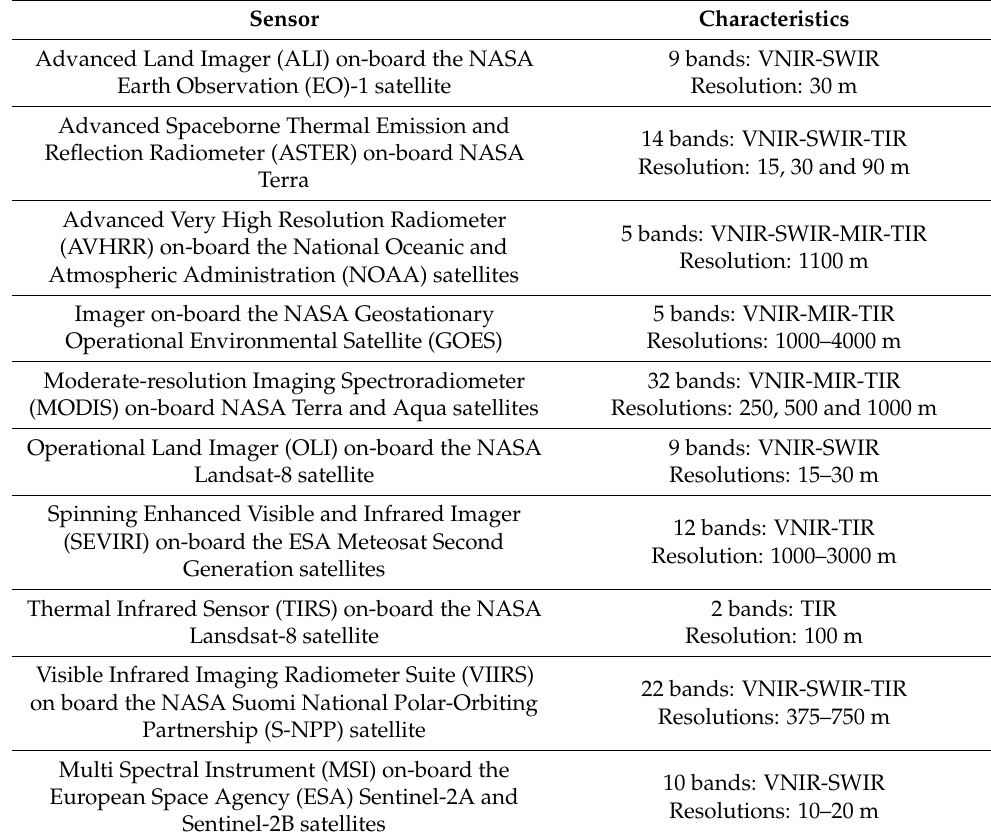
Table 1. Characteristics and attributes of some sensors used for the optical monitoring of volcanoes by satellite (VNIR: visual and near infrared; SWIR: short-wave infrared; MIR: mid-infrared; TIR: thermal infrared). (Updated after